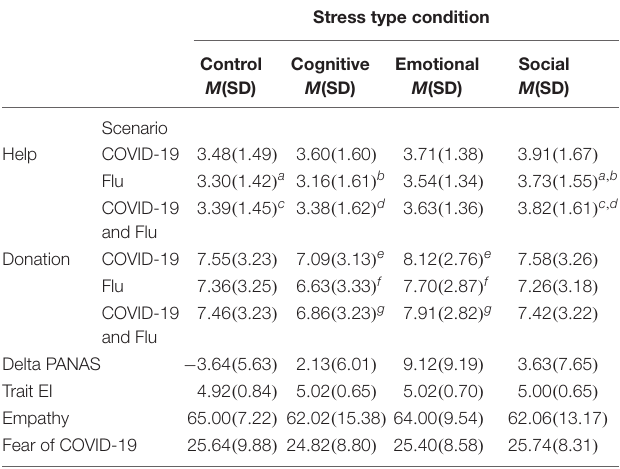
TABLE 1 | Descriptive statistics of main study